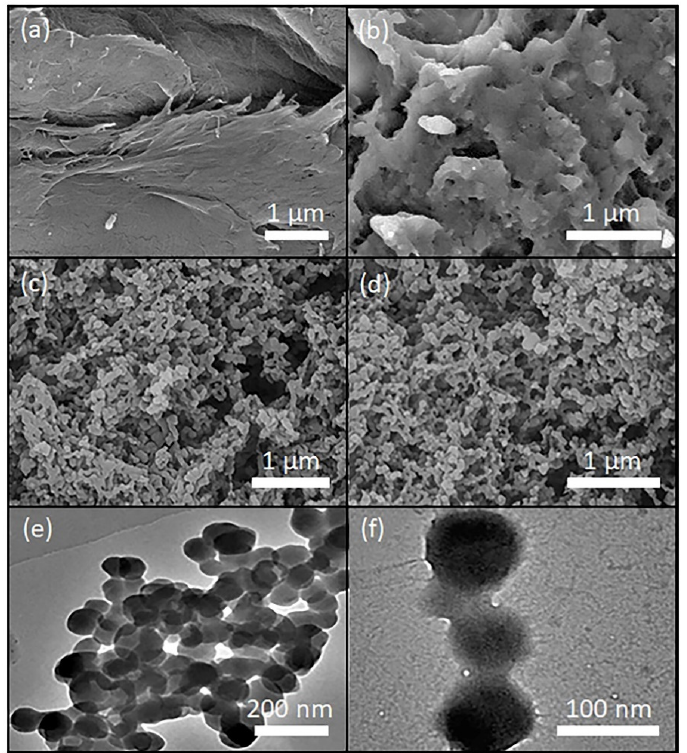
Figure 4. SEM images of ( a ) pristine, ( b ) NCS2, ( c ) NCS4 and ( d ) NCS7 chitosan samples. The TEM images of NCS7 are shown in ( e , f ).